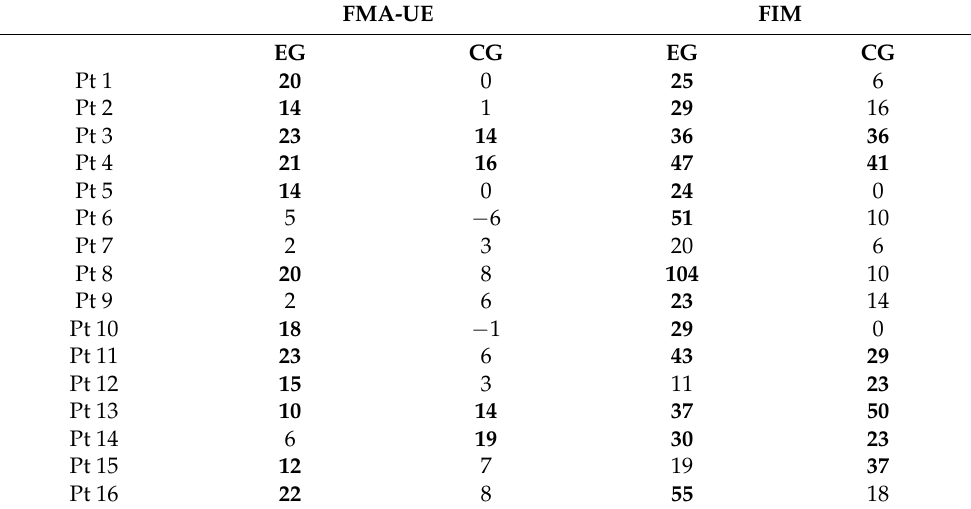
Patients that overcame the minimum clinically important difference (MCID) for FMA-UE (MCID = 9) and for FIM (MCID = 22) are shown in